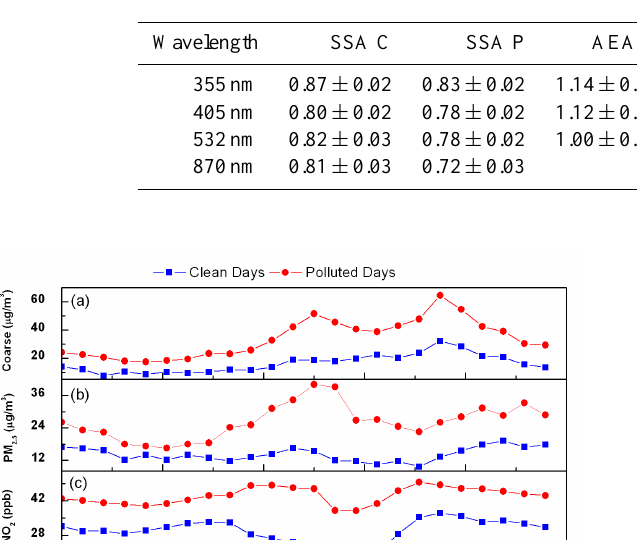
Table 1. Mean values of SSA, AEA, and AES for clean (C) and polluted (P) days. For AEA and AES the reference wavelength is 870nm.